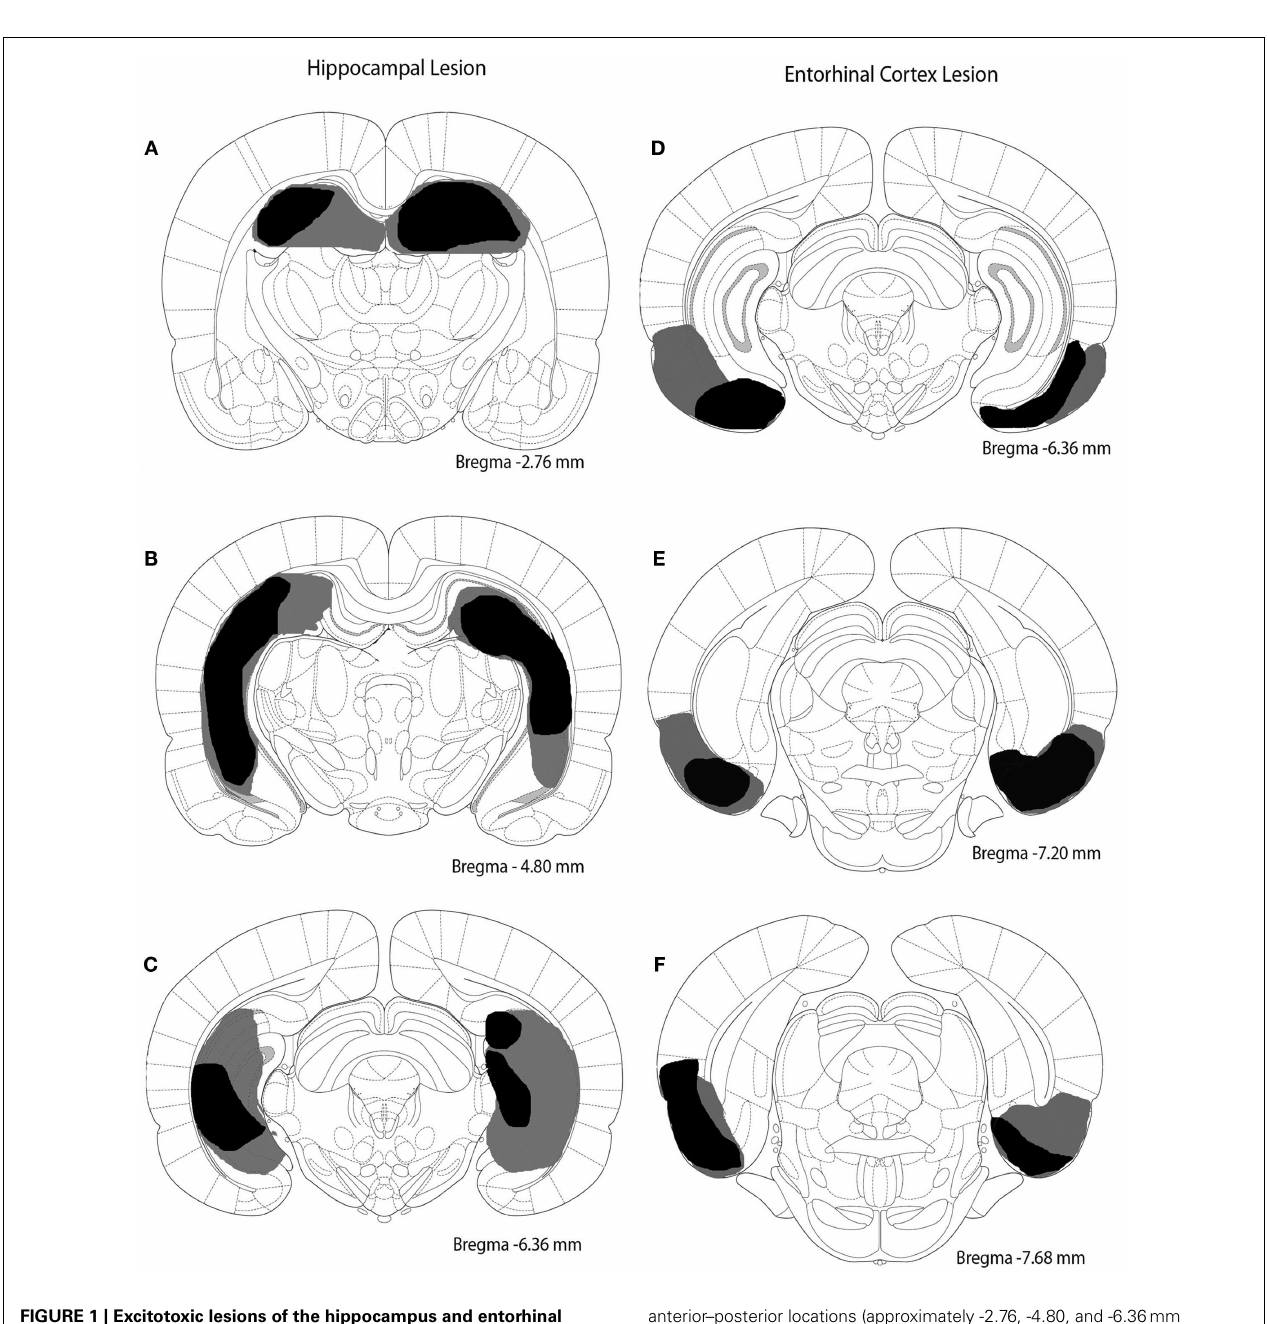
FIGURE 1 | Excitotoxic lesions of the hippocampus and entorhinal cortex .The black shaded regions indicate the smallest lesion observed and gray shaded regions indicate the largest lesion observed. (A–C) depict the hippocampal lesion at three different